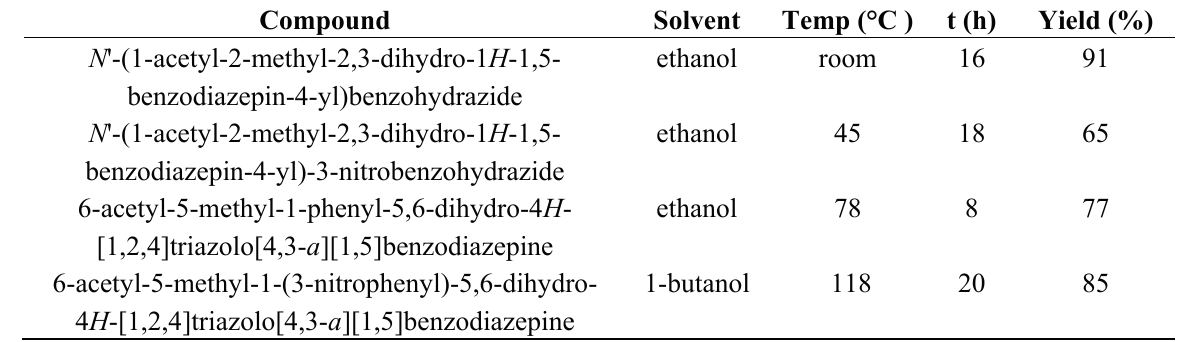
Table 2. Favorable reaction conditions for the synthesis of